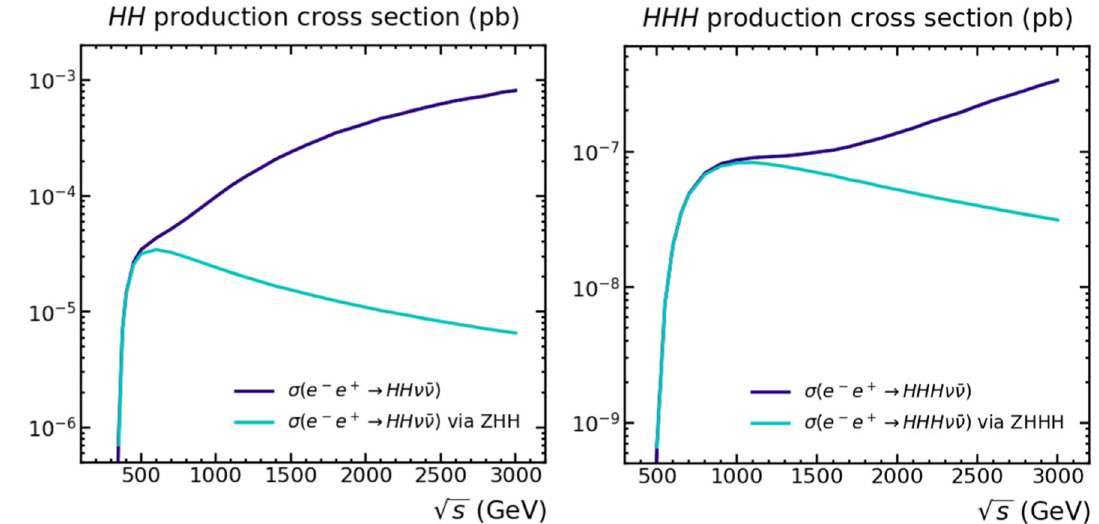
√ s .Thecorresponding